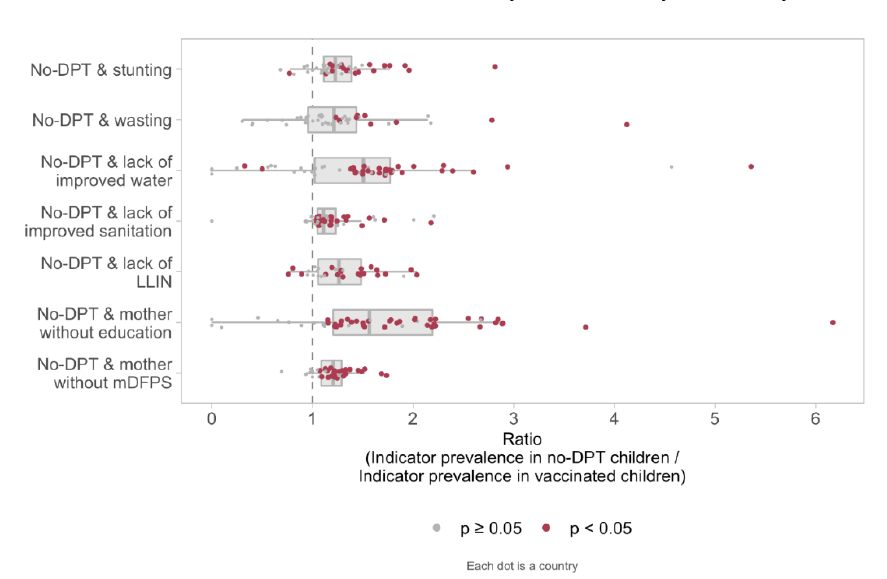
Figure 1. Distribution of no-DPT prevalence ratios according to deprivation indicators in the individual-level analyses in 80 countries (39 countries for bed nets). Each dot represents one country and red dots indicate PRs for which the 95% CI did not include unity. Note: The extreme left of box represents the 25th percentile and the extreme right the 75th. The vertical line within the box